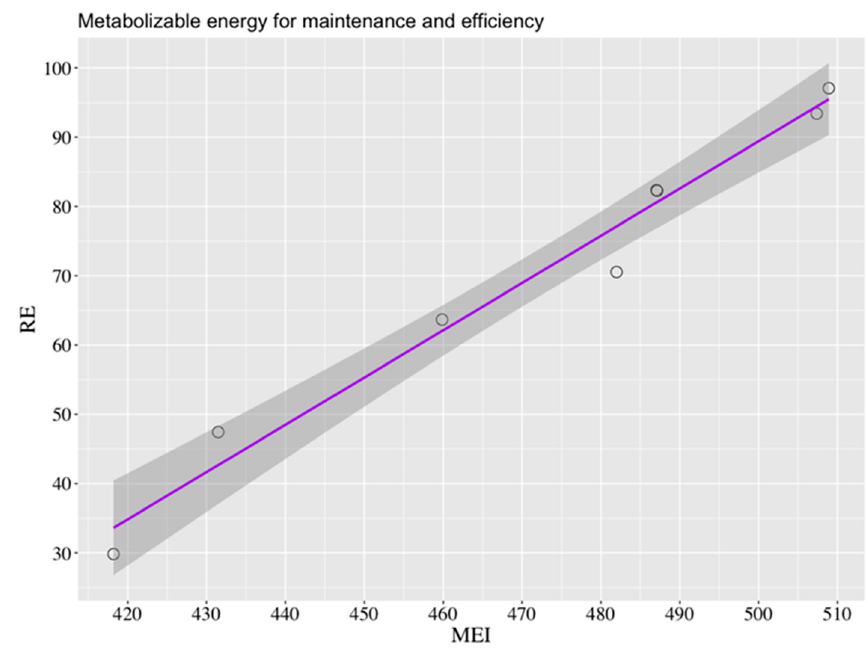
Figure 4. Regression analysis of RE over MEI expressed in kJ/kg BW 0.75 .